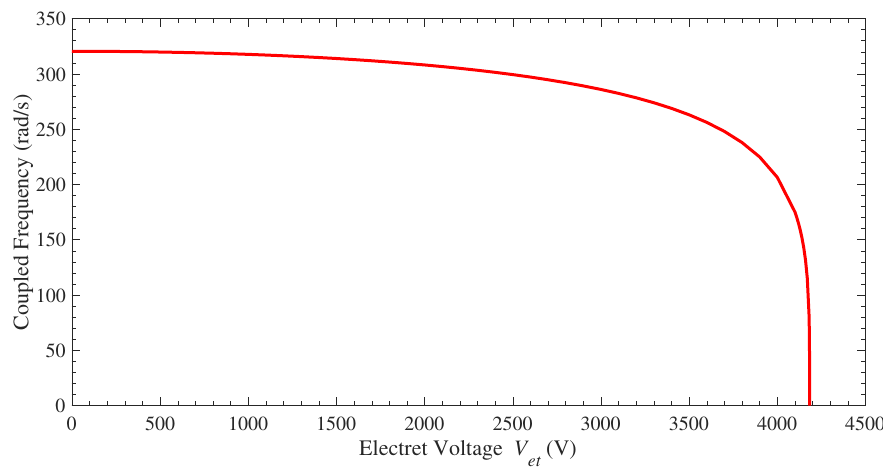
Figure 5. Variation of the coupled frequency as a function of the electret